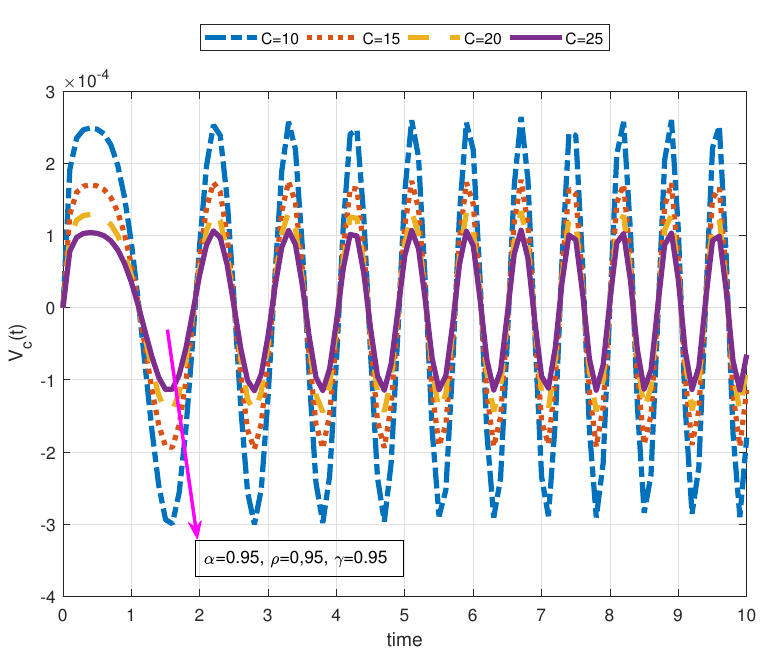
Figure 8. This figure corresponds to the function V c ( t ) with an oscillatory source for some values of α , ρ , and γ in order to show the effect of capacitance on solution curves when α = 0.95, ρ = 0.95, γ = 1.5, C = 10 F, e 0 = 10 V, and θ = 60 Hz, V c ( 0 ) =